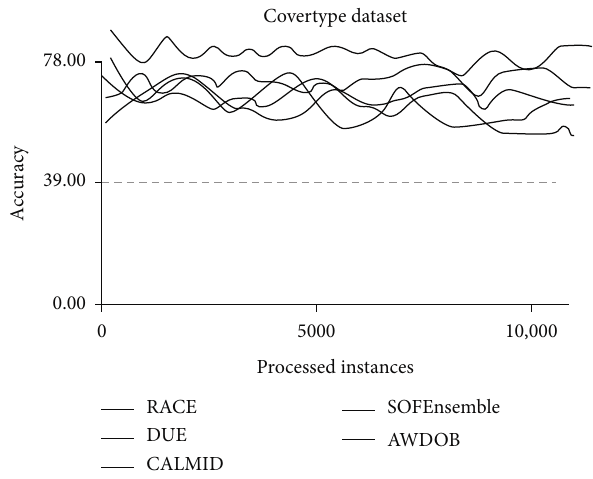
Figure 9: Prediction accuracy of the five algorithms on the Covertype dataset.